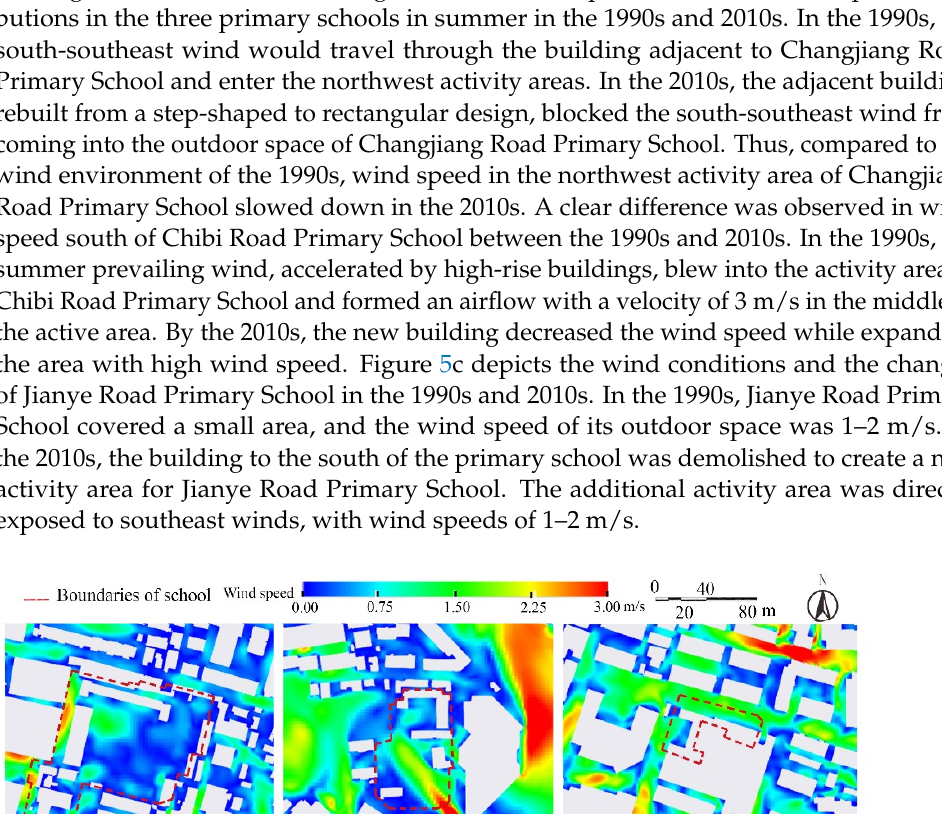
Figure 6. Wind speed distributions at the pedestrian level in three primary schools in summer in the 2010s: ( a ) Changjiang Road Primary School; ( b ) Chibi Road Primary School (Shanxi Road Cam- pus); ( c ) Jianye Road Primary School. Figures 7 and 8 illustrate the wind environment of three schoolyards at the pedestrian level in winter in the 1990s and 2010s. In winter, similar to in summer, the reconstruction of buildings led the wind speed at the gate of Changjiang Road Primary School to slow down in the 2010s, compared with the 1990s. In the winter of the 1990s and 2010s, the buildings of Chibi Road Primary School (Shanxi Road Campus) blocked east-northeast winds from entering the eastern part of the schoolyard. However, the wind speed in the south of the schoolyard during both periods was 1–2 m/s. For Jianye Road Primary School, the wind speeds of the original outdoor spaces were lower in both periods. However, in the 2010s, east-northeast winds that run along low buildings were inducted into the new outdoor spaces with higher wind speeds than in the 1990s.